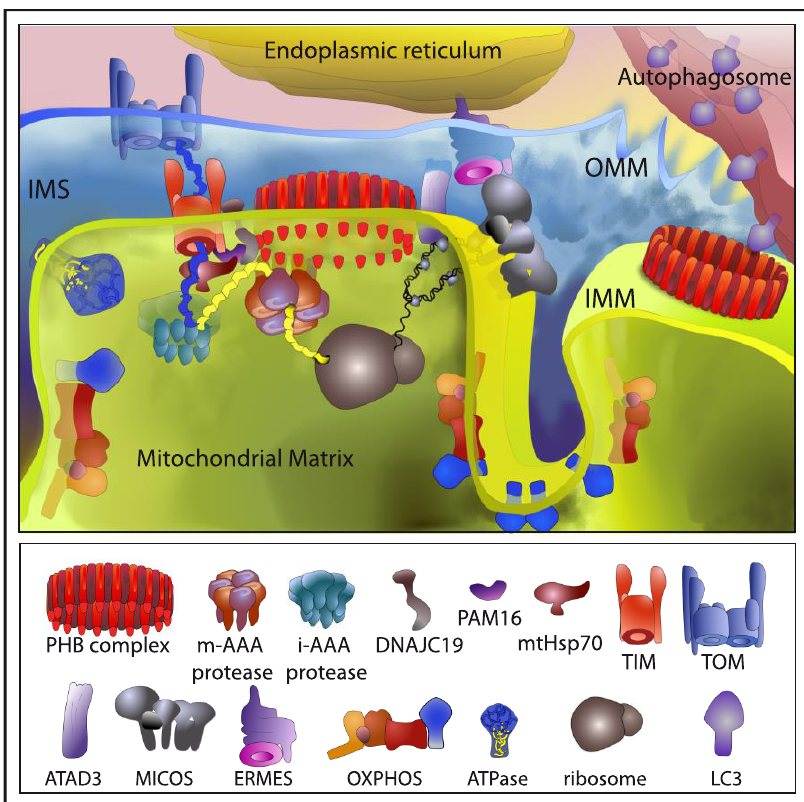
Figure 2. The role of the prohibitin (PHB) complex in mitochondrial homeostasis and turnover. Interactions involved in mitochondrial biogenesis are depicted in the left side, those involved in mitophagy in the right side. Both, physical and genetic interactions described for the PHB complex are depicted. PHB complex is involved in organization and stability of mitochondrial nucleoids together with ATAD3 in human cells. In yeast, as well as in mammals, prohibitins stabilize newly